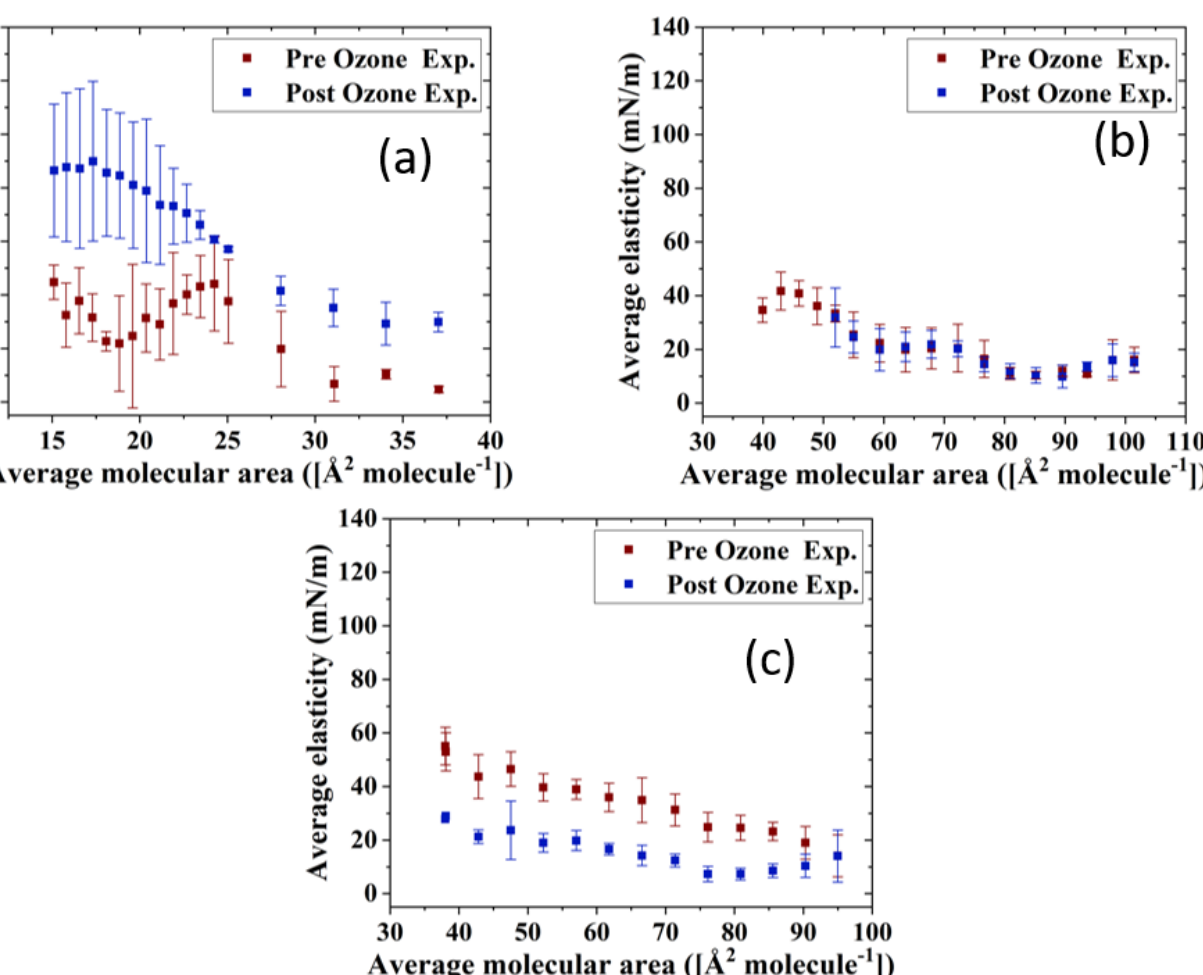
Figure 8. Surface dilational elasticity data of ( a ) CO:PC 90:10 (binary mixture); ( b ) CO:GT:PC 40:40:20 (ternary mixture); and ( c ) CO:GT:FFA:PC 40:25:15:20 (quaternary mixture) before ozone exposure (red) and after ozone exposure (blue) on PBS at 22 °C.